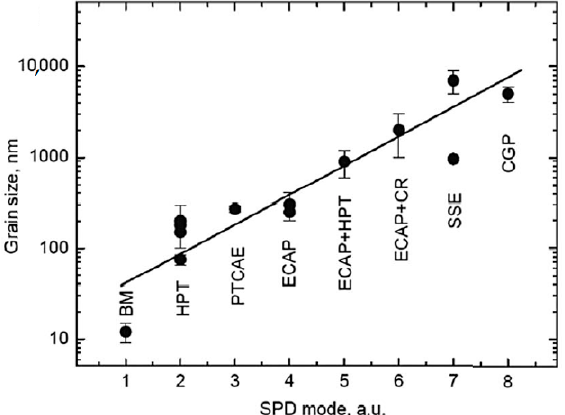
Figure 1. Comparison of grain sizes obtained in extreme plastic deformation methods (BM: Ball Milling, HPT: High-Pressure Torsion, PTCAE: Planar Twist Channel Angular Extrusion, ECAP: Equal Channel Angular Pressing, CR: Cold Rolling, SSE: Simple Shear Extrusion, CGP: Constrained Groove Pressing) [7].